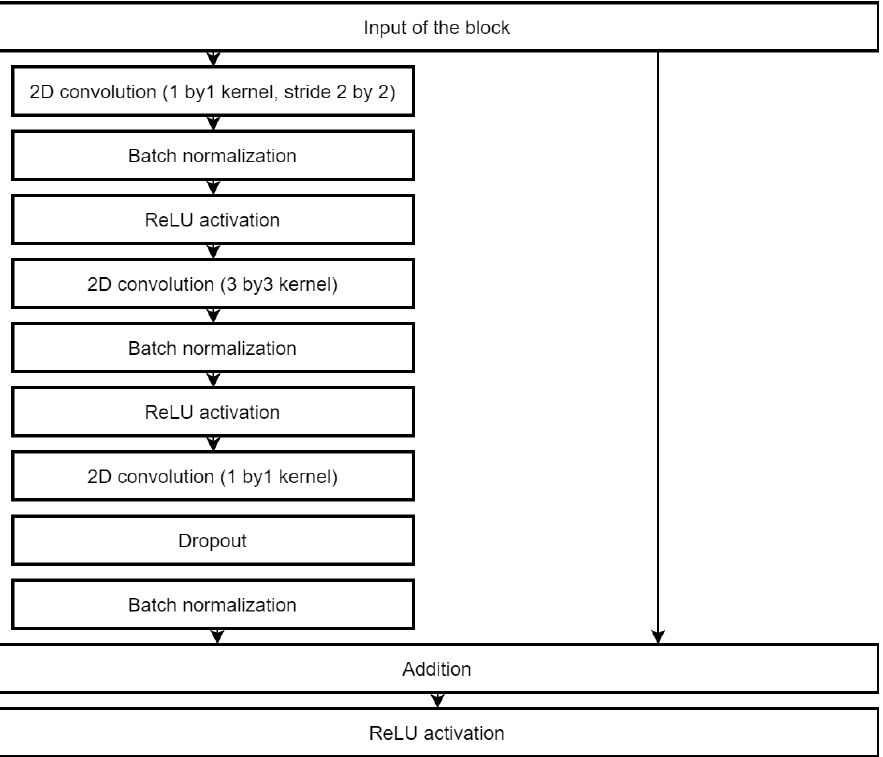
Figure 5. The convolution residual block used in the main classification model.